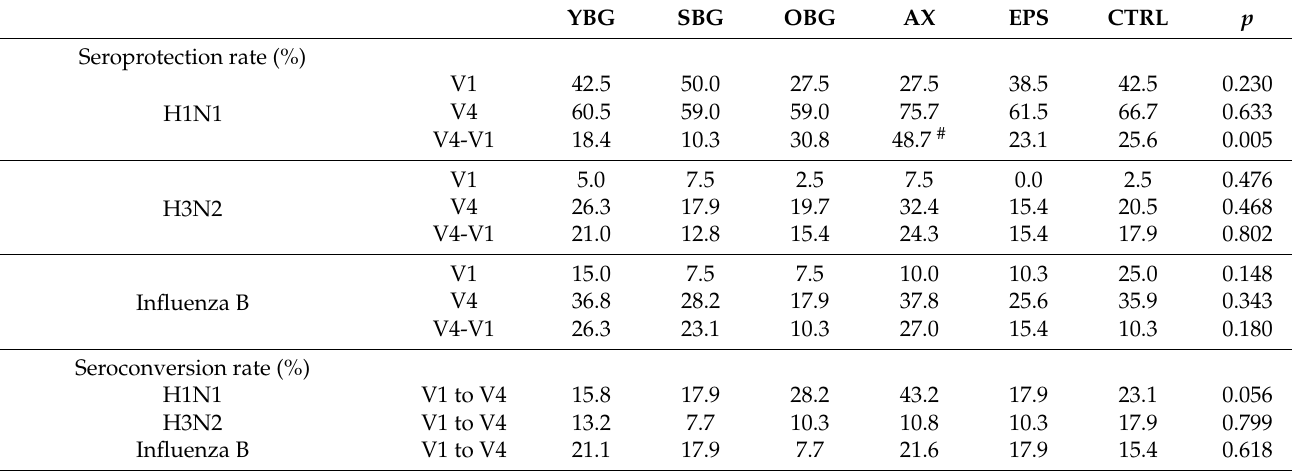
Table 3. Changes in seroprotection and seroconversion rate in the haemagglutination inhibition (HI) assay between baseline (V1) and three weeks after vaccination (V4) in the different NPS intervention